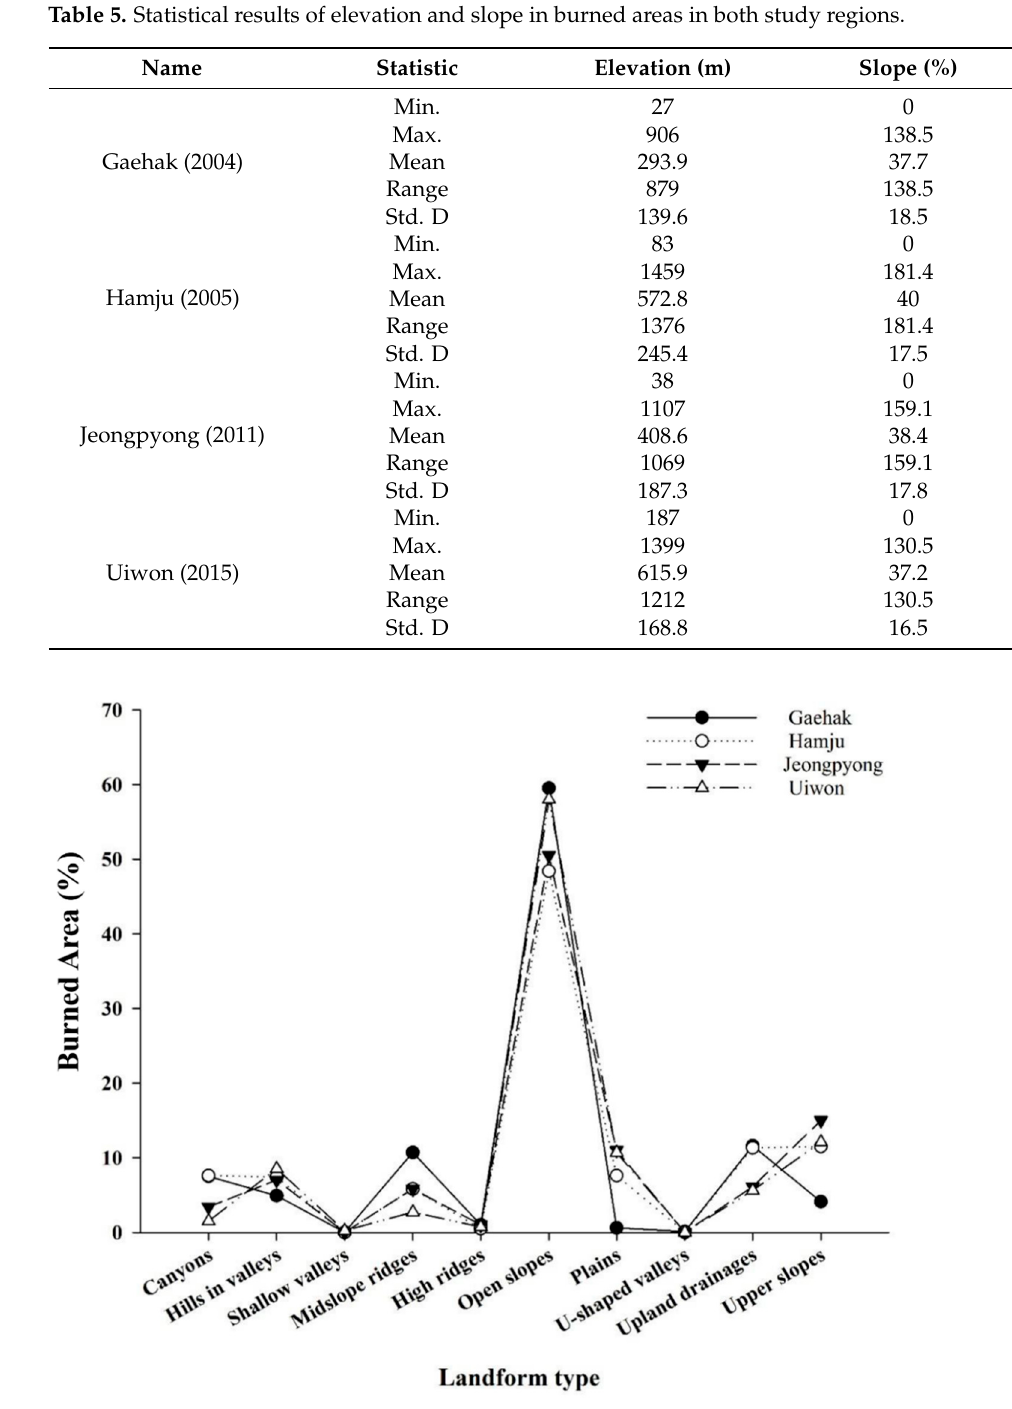
Figure 12. Distribution of landforms of the four burned areas in this